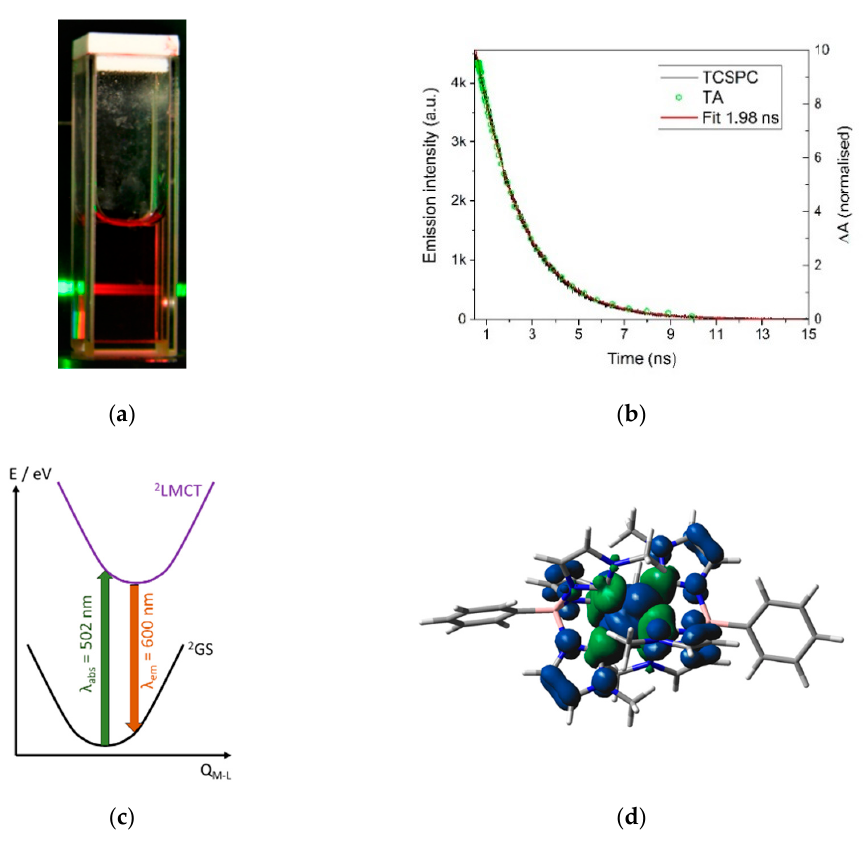
Figure 14. Photophysics and electronic structure properties of complex 29 [54]. ( a ) Photoluminescence of complex 29 under 502 nm irradiation; ( b ) ~2 ns lifetime measurements of complex 29 by transient absorption (TA) and time-correlated single photon counting (TCSPC). ( c ) Doublet ground state ( 2 GS) and ligand-to-metal charge transfer ( 2 LMCT) excited state potential energy landscape, including arrows indicating the doublet-doublet excitation and deactivation. ( d ) Ground state spin density from density functional theory calculations. Table 3. Photo(electro)chemical properties of Fe(III)NHC complexes. All measurements in CH 3 CN unless otherwise noted. Electrochemical measurements conducted in CH 3 CN against Fc +/ 0 and converted to corresponding standard NHE values using a standard reference electrode conversion constant of + 0.630 V